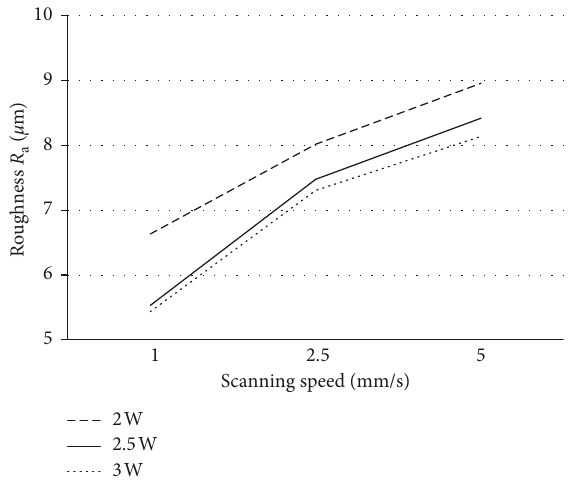
Figure 6: Roughness of laser-processed surfaces.